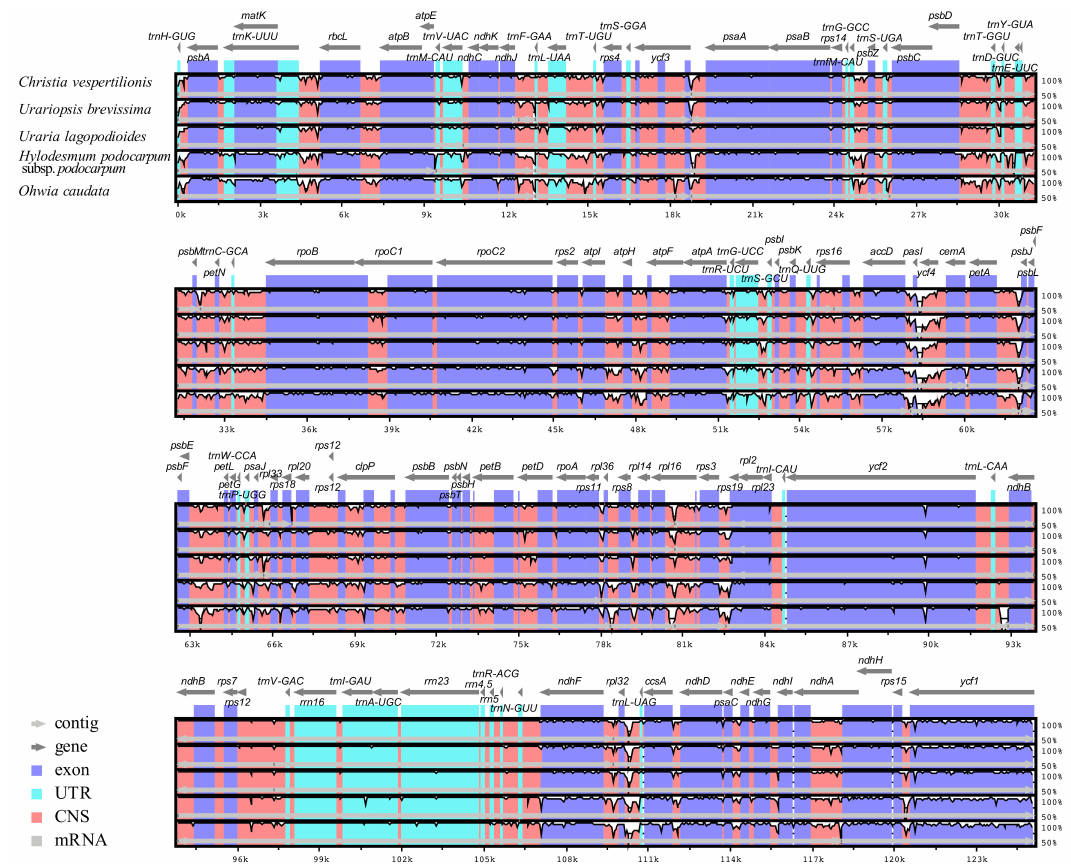
Figure5. AlignmentofthechloroplastgenomesofsixDesmodieaespecies, using Desmodiumheterocarpon as a reference. The Y-scale represents the percent identity ranging from 50% to 100%.